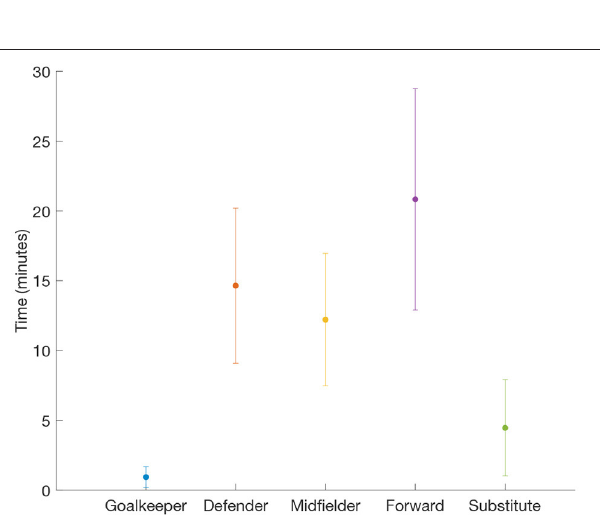
FIGURE 4 | Aggregated time by player position. Average time | t aggr | that a player, according to his position, has accumulated with at least one rival at a distance closer than D = 2 m. Dots are the average by position and error bars are the corresponding standard deviation. Note that, as suggested by Figure 2 , forwards are players that accumulate more time close to their